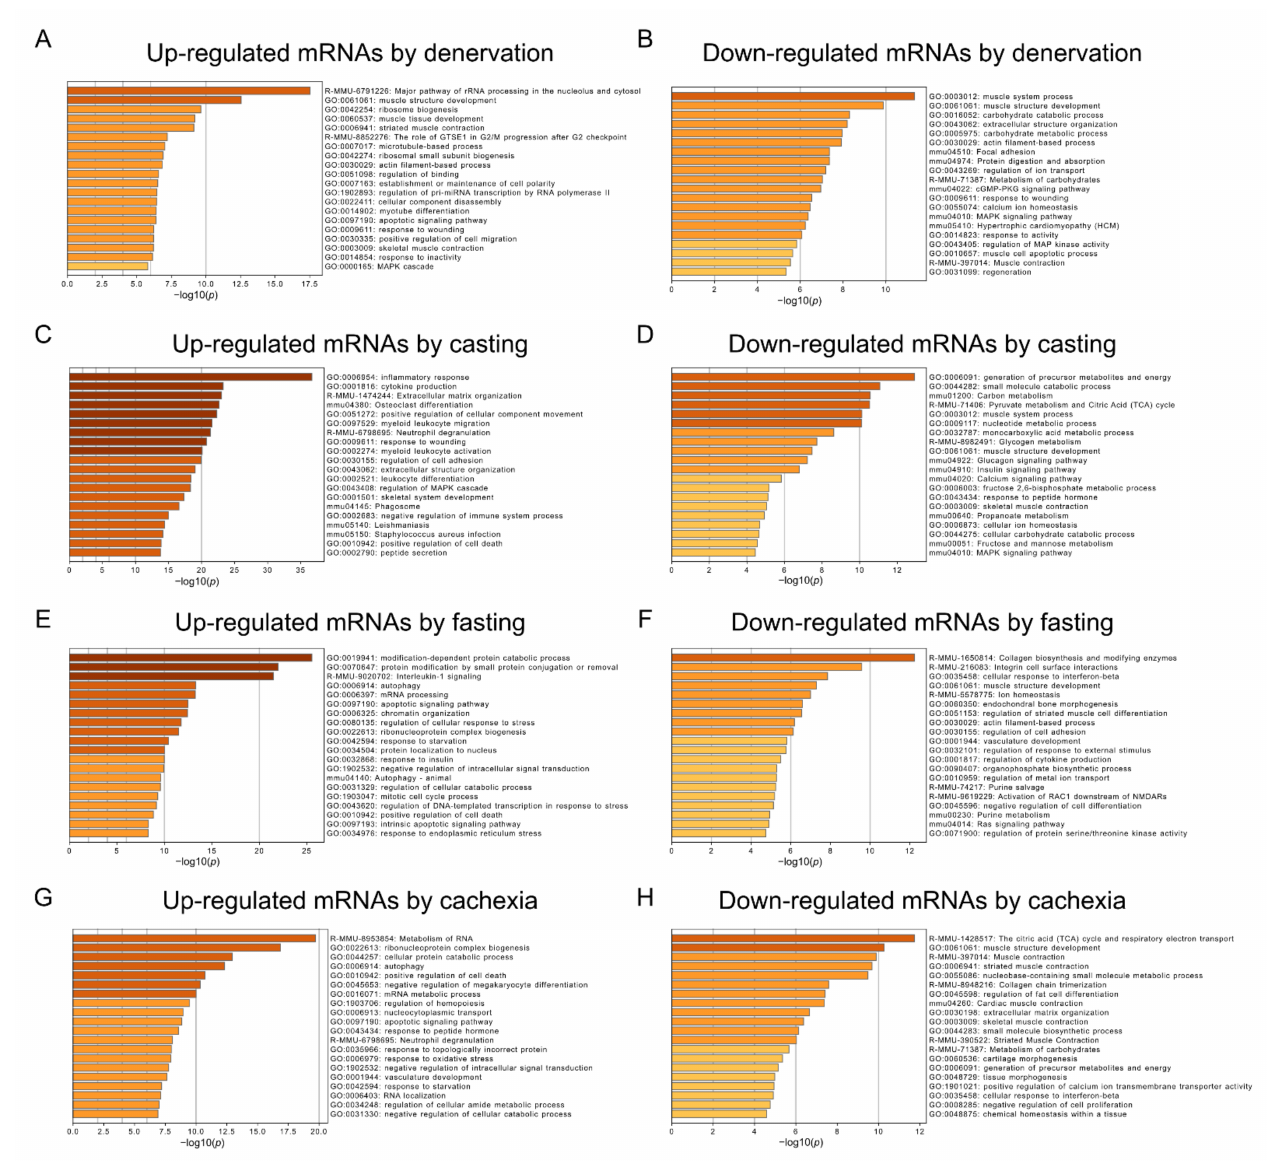
Figure 3. Functional enrichment analysis of differentially expressed mRNAs in each muscle atrophy condition. Enriched biological processes were ranked by p -value. Bar graphs show the top, non-redundant enrichment clusters (Metascape analysis) for up- or down-regulated mRNAs in response to denervation ( A , B ), casting ( C , D ), fasting ( E , F ), and cancer cachexia treatment ( G , H ). The x -axis represents the − log10 ( p